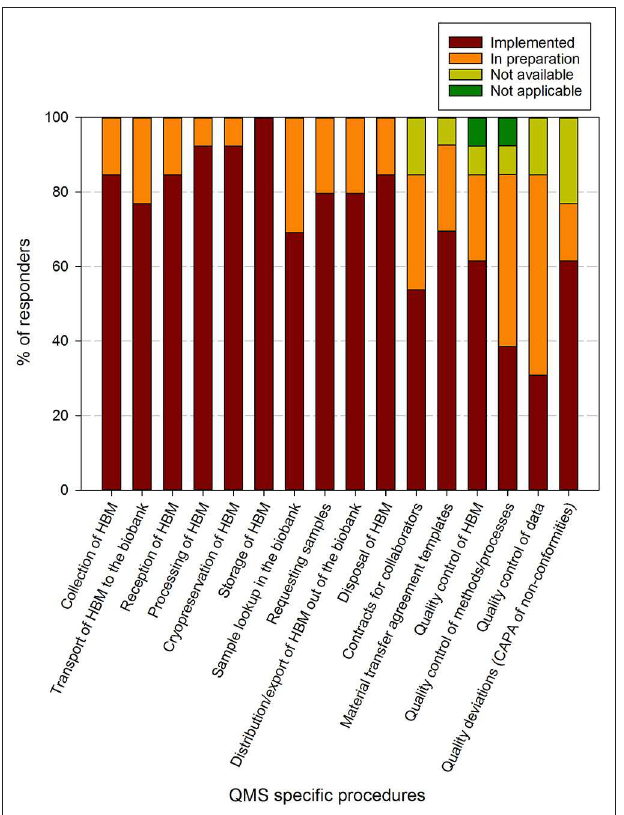
FIGURE 5 | Implementation status of biobank specific procedures in biobanks in the BBMRI.be network. Participants were requested to indicate for each item in a list of specific procedures/items whether these were fully implemented (brown), in preparation (orange), not available (lime-green), or not applicable (dark green). The items listed were collected and aggregated from the ISBER best practices for biorepositories, the ISO 20387 and ISO 9001 standards. All participants responded to all items listed. The list of items asked is displayed in the X-axis.